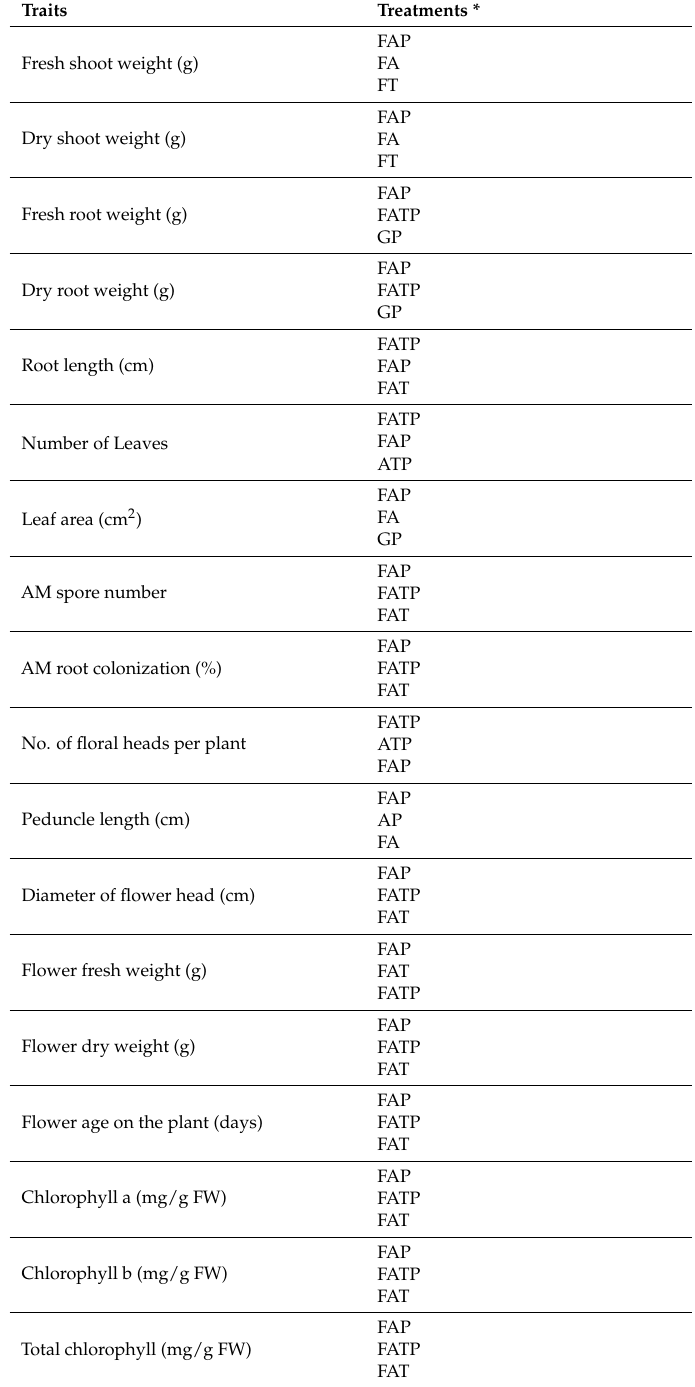
Table 5. Top three treatments for morphological, floral and biochemical traits studied in Gazania rigens . Traits Treatments